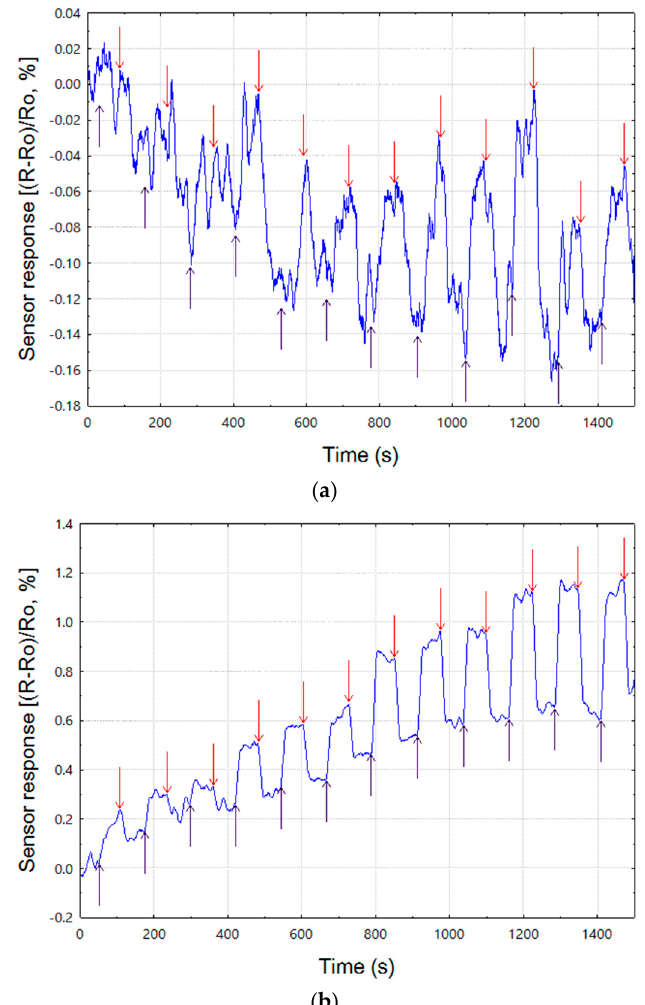
Figure 7. Transient responses of chemosensitive resistors coated with carbon black composites containing ( a ) THEED; and ( b ) PEG20M to vapors of pyrrole (3 triplicates at 4 concentrations).